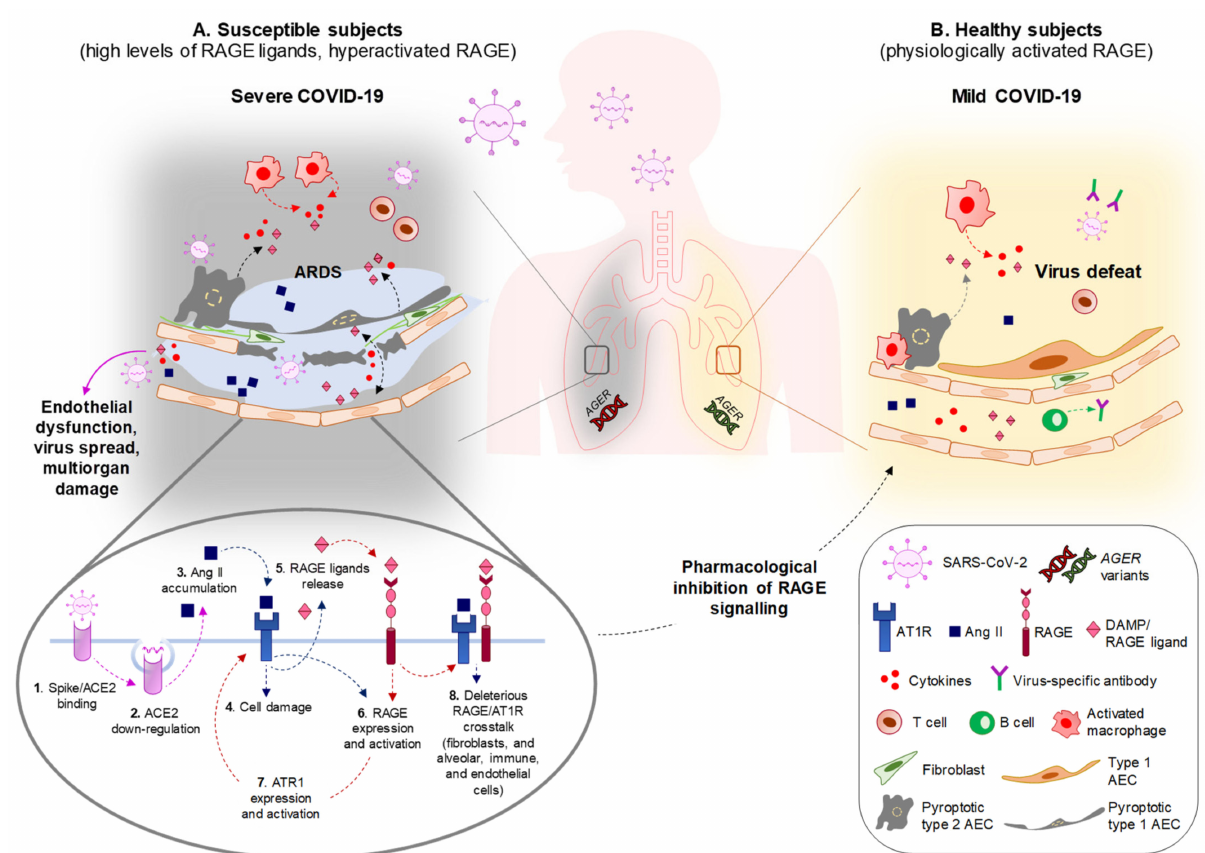
Figure 3. ( A ) In susceptible subjects (i.e., aged subjects and patients with preexisting comorbidities) a basal state of lung inflammation and high levels of circulating RAGE ligands occur, predisposing them to severe COVID-19. Upon recognition and binding of the viral spike protein with ACE2 receptor (1), SARS-CoV-2 enters type 2 alveolar epithelial cells (AEC) and leads to downregulation of ACE2 (2), resulting in the unopposed accumulation of Ang II (3), which mediates the inflammatory response and parenchymal injury in the lungs (4). Infected AECs undergo pyroptosis and release DAMPs, including RAGE ligands (5), leading to excess RAGE expression and activation (6). In these conditions, RAGE activity increases AT1R expression (7), and might transactivate AT1R, reinforcing the deleterious effects of Ang II/AT1R in alveolar epithelial, immune, and endothelial cells, and in fibroblasts (8). Ang II/AT1R induce the further release of RAGE ligands (5), thus establishing a detrimental loop between AT1R and RAGE signaling. The result is increased capillary permeability, interstitial edema, fibrosis, further cytokine-dependent parenchymal epithelial and endothelial damage, and chronic inflammatory cell recruitment and activation, i.e., ARDS. The virus, together with RAGE ligands and a cytokine storm, enters the bloodstream, also favored by the disruption of the capillary integrity, reaching organs in which deleterious RAGE/AT1R crosstalk might be already active, and causing irreversible multiorgan damage, potentially culminating in the patient’s death. ( B ) In this scenario, the pharmacological inhibition of RAGE restores the physiological activity of the receptor, as occurs in healthy subjects, resulting in mild COVID-19 upon SARS-CoV-2 infection. The absence (in healthy subjects) or destruction (in susceptible subjects treated with RAGE inhibitors) of the deleterious RAGE/AT1R crosstalk might result in restrained lung damage and an improved immune response, avoiding the cytokine storm and favoring the production of neutralizing antibodies, and the removal of infected cells and the virus. Specific AGER variants might predispose patients to or protect them against COVID-19 comorbidities, and dictate the outcome of COVID-19